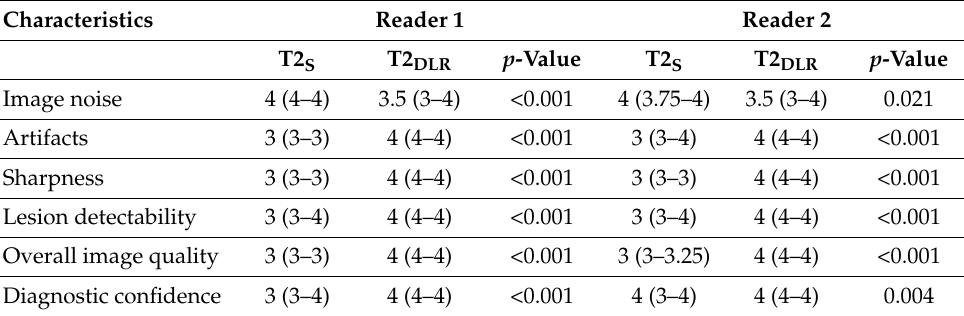
Table 3. Median (interquartile range) image quality in standard T2-weighted imaging (T2 S ) and deep learning reconstructed thin-slice T2-weighted imaging (T2 DLR ). Likert-scale ranging from 1–4 with 4 being the best